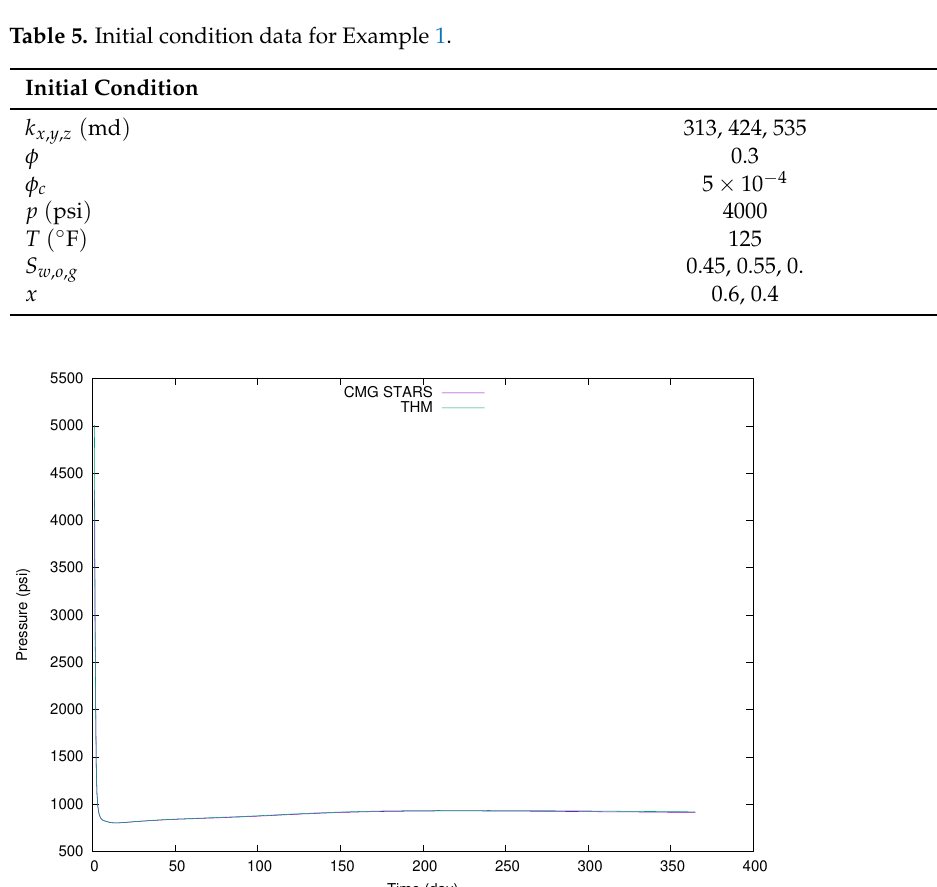
Figure 1. Example 1, injection well, bottom hole pressure